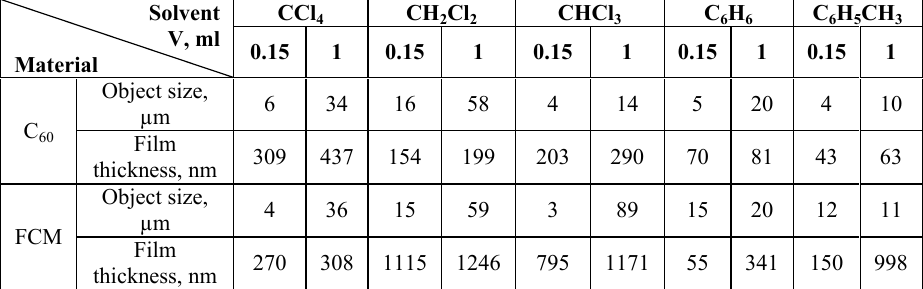
Table 1. Geometry of thin-film structures based on C 60 and obtained with the use of various solvents.